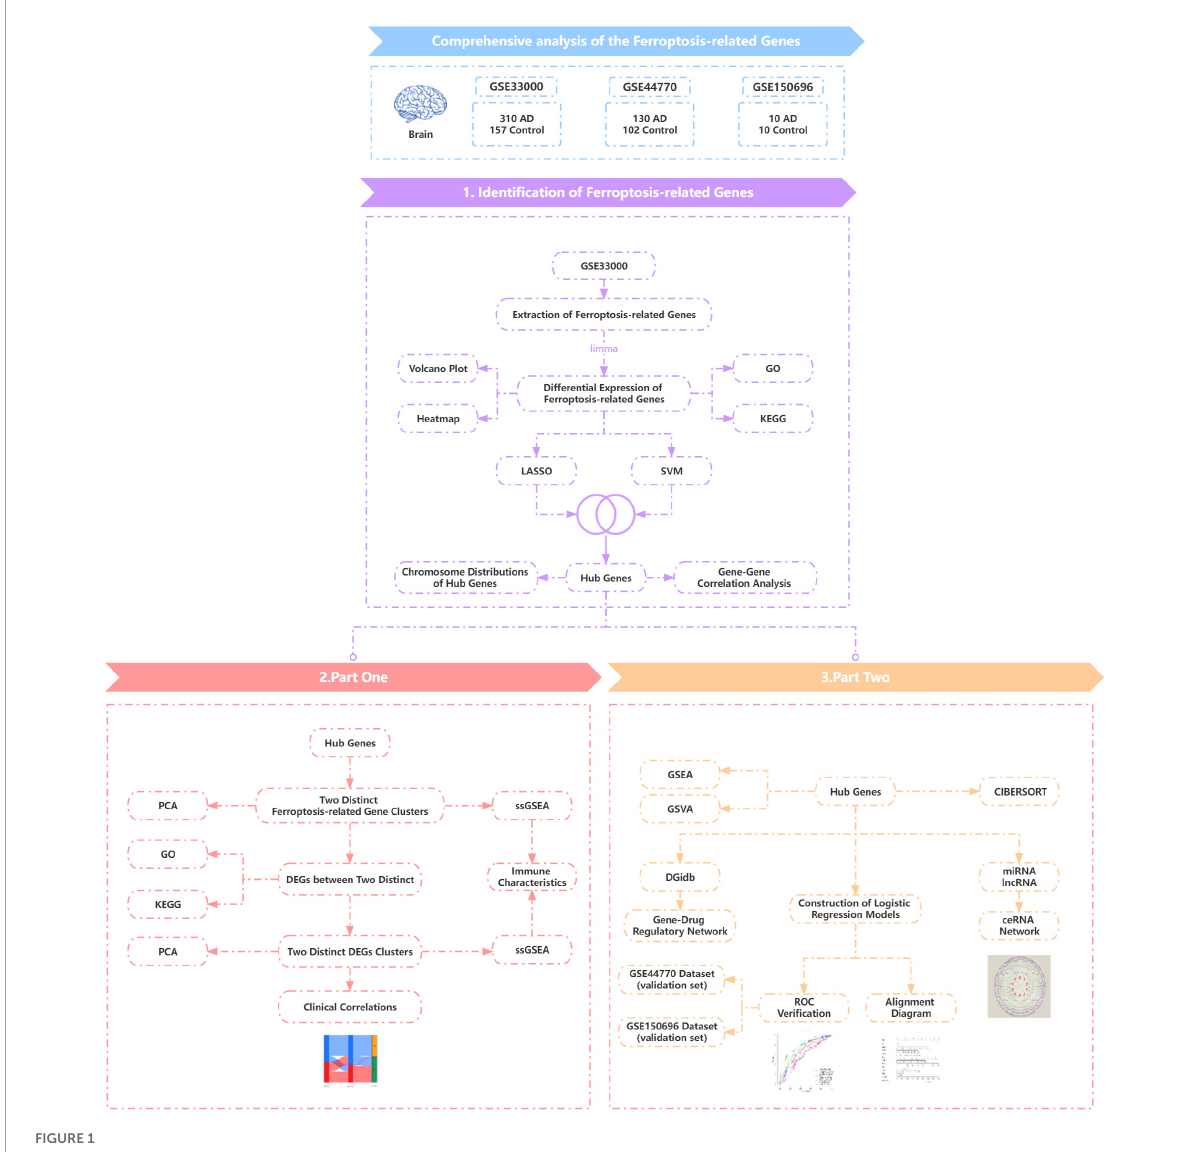
FIGURE1 Technology route. AD, Alzheimer’s disease; Control, healthy